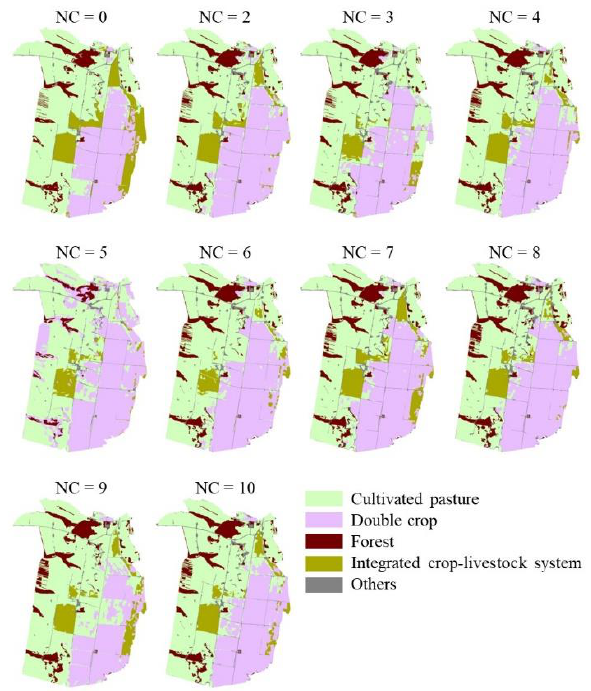
Figure 3 . Map predictions of classification tests, where NC: number of